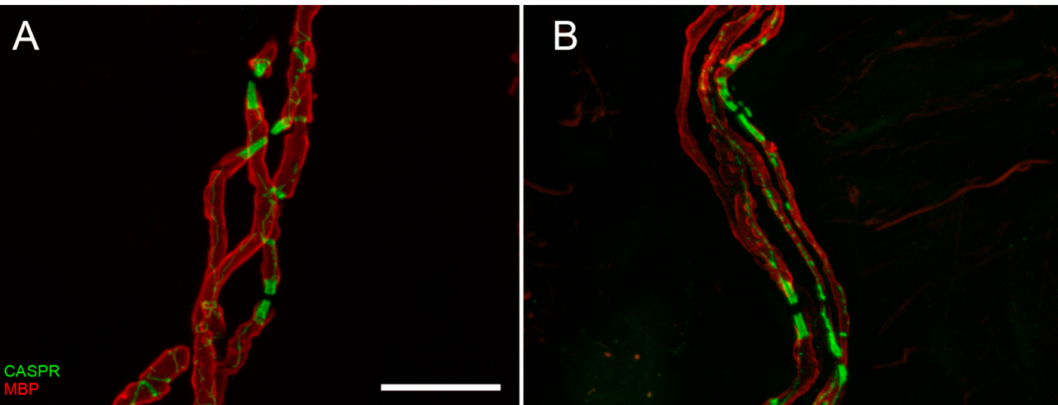
Figure 3. Confocal digital images of myelinated nerve fiber bundles in a control ( A ) and a diabetic patient ( B ). The double staining with anti-myelin basic protein (MBP, in red) and anti-contactin associated protein (CASPR, in green) allows to appreciate the nodal and paranodal architecture that is regular and symmetric in normal conditions, asymmetric and deranged in case of peripheral neuropathy. Scale bar: 20 µ